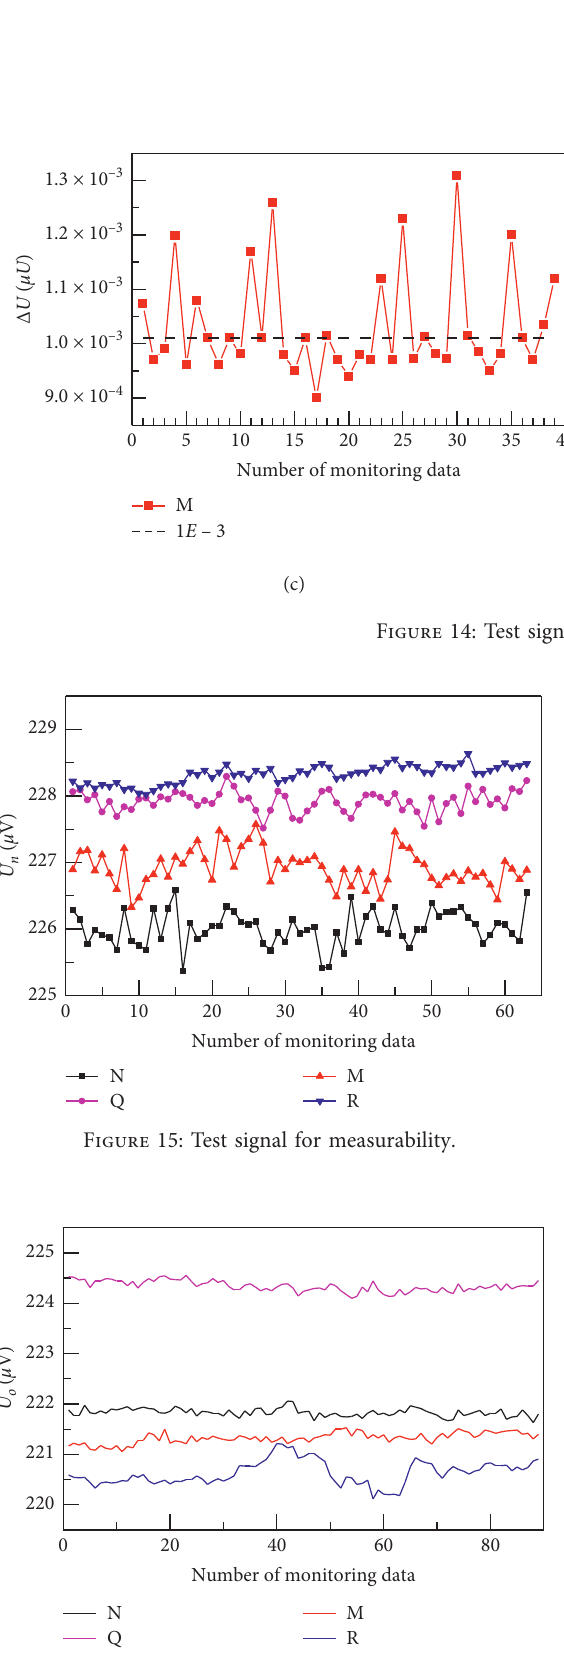
Figure 16: Test signal for the main